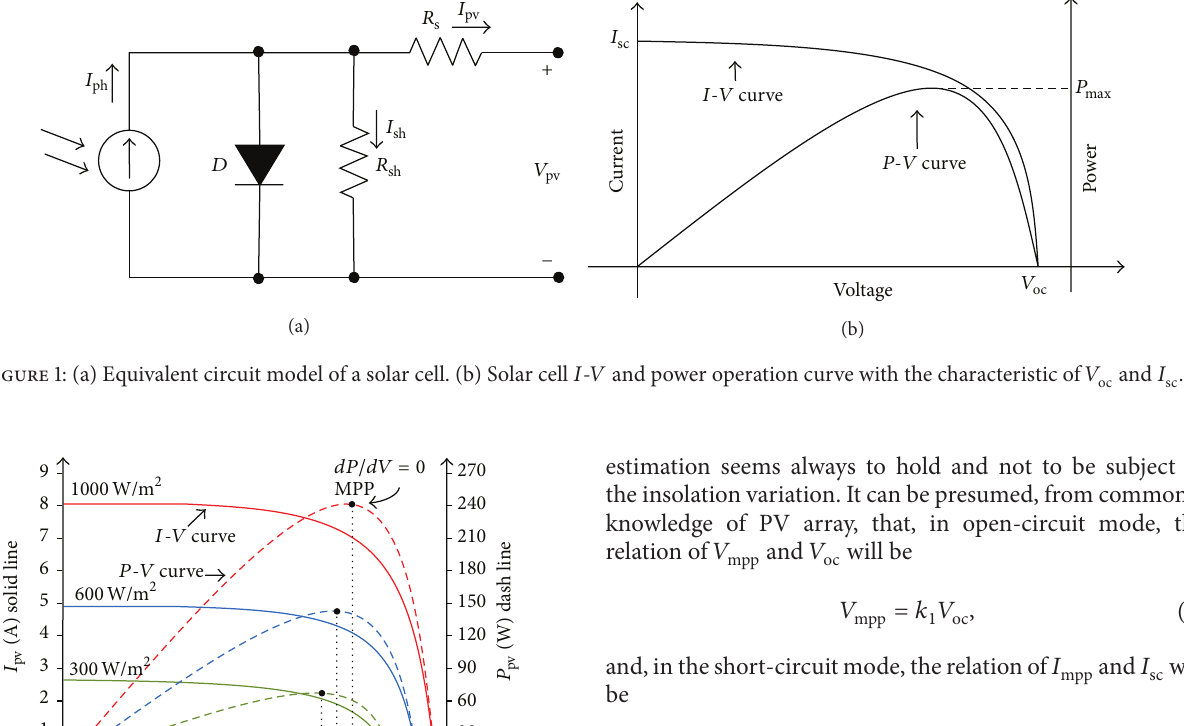
- 𝑉 and 𝑃 - 𝑉 characteristics of different irradi- pv pv pv pv